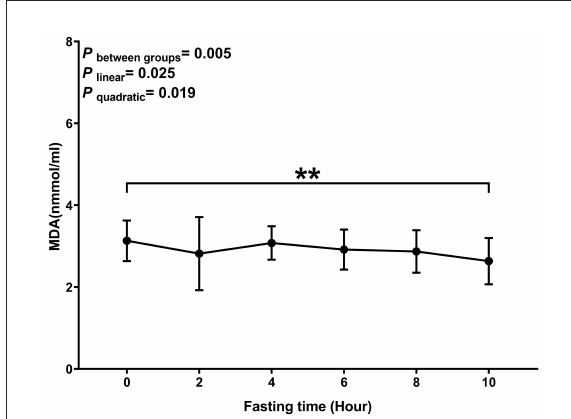
FIGURE4 Postprandial changes in plasma SOD. Data are presented as the means, with the error bars representing the 95% confidence intervals of the means. *Indicates a statistically significant difference of SOD at the 10th hour as compared with the other time points at alpha = 0.05; all statistically significant differences are